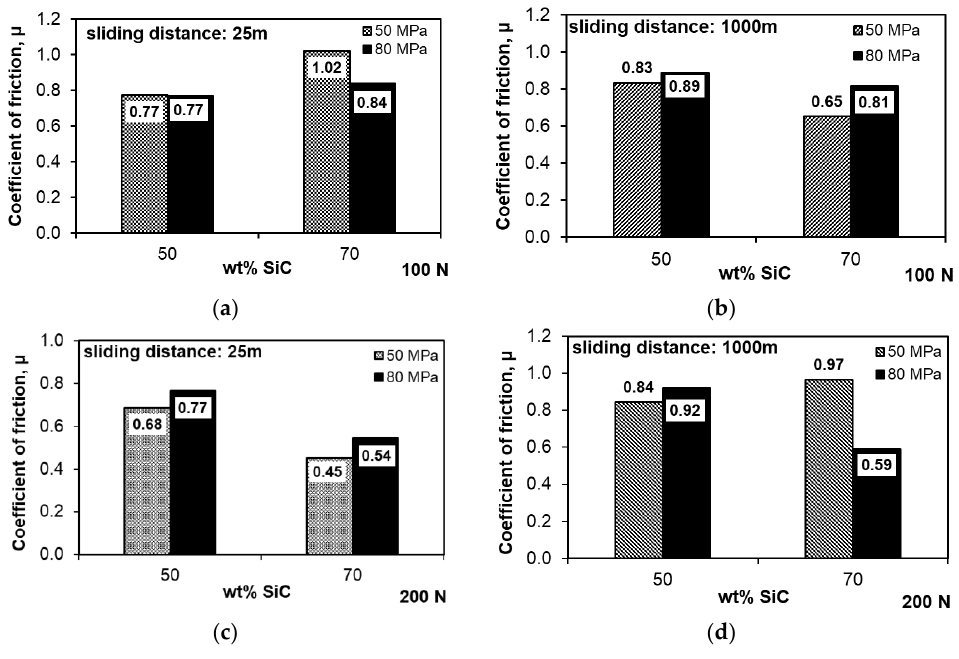
Figure 7. Variation in coefficient of friction in composites: ( a , b ) Load 100 N; ( c , d ) load 200 N.